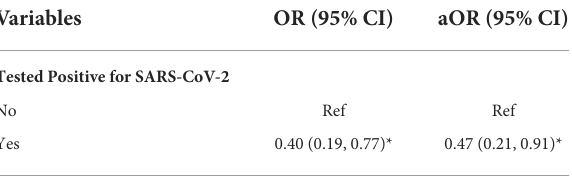
TABLE 4 Associations between testing positive for SARS-CoV-2 and sleep duration, september 2020 ( n = 1,058) Odds Ratio (95%